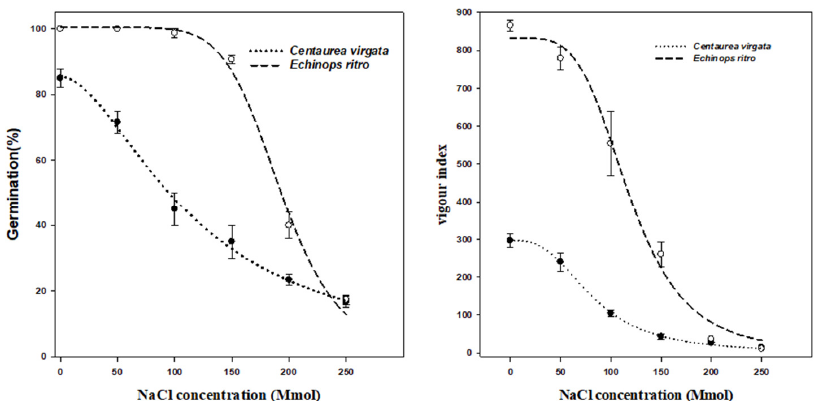
Figure 2. Fitted nonlinear regression model on the data obtained from seed germination and seedling vigor of Echinops ritro and Centaurea virgata under salinity